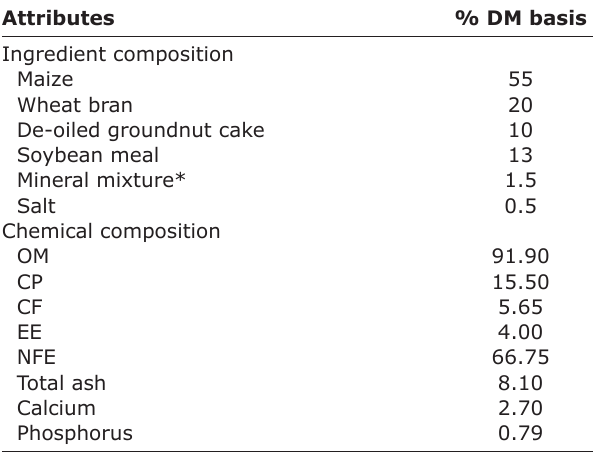
Table-1: Ingredient and chemical composition (% DM basis) of experimental basal diet for grower